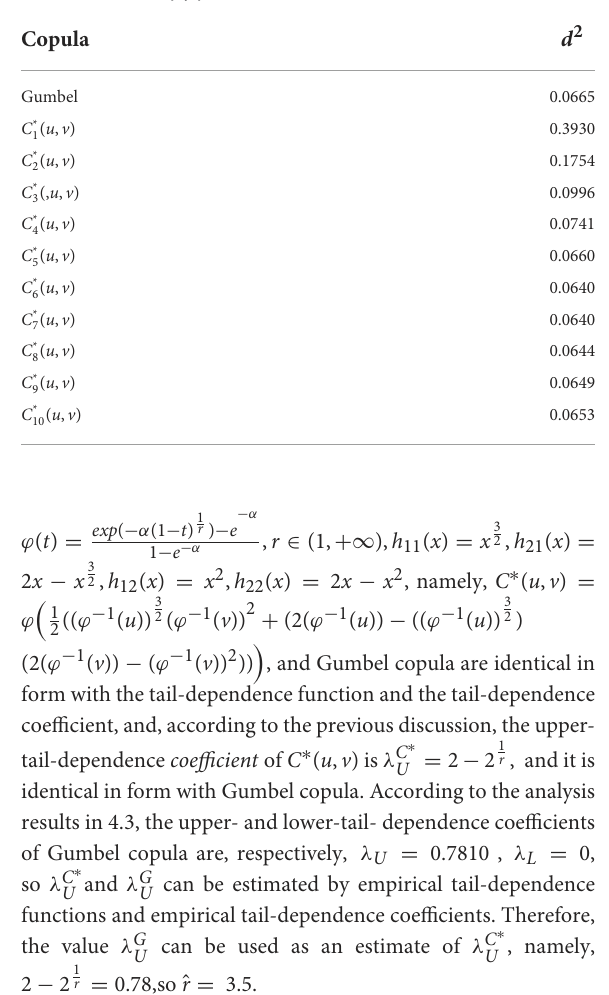
TABLE 3 Parameter estimation of the copula function. TABLE 4 d 2 of C * (u,v) and